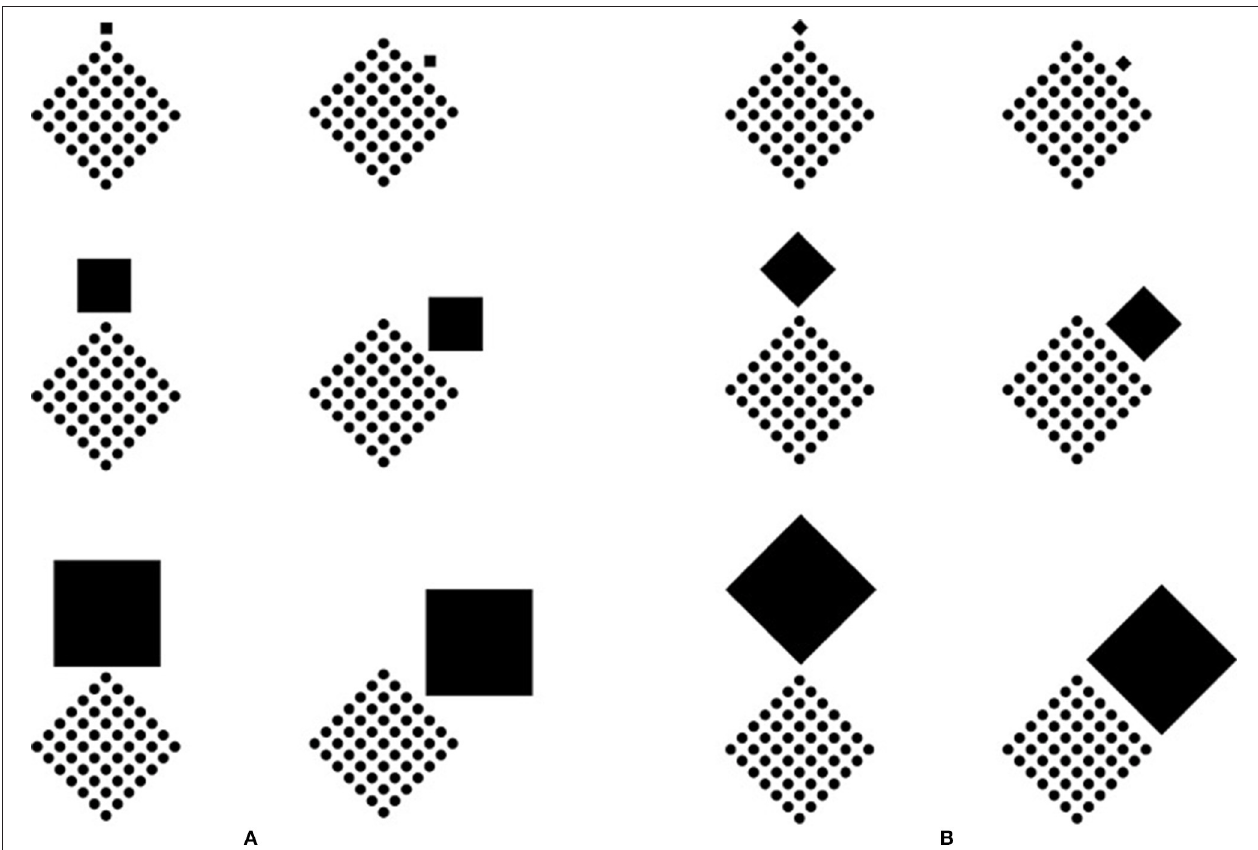
FIGURE 8 | By comparing all the conditions, both the dissimilar element [a square in (A) and a diamond in (B)], and the set of circles influence each other in the perceived grouping (for the circles, see the text) and in the shape [for both the array of circles and the dissimilar element, e.g., the large black shape is perceived as a square in the first column of (A) and in the second of (B), and as a diamond in the second column of (A) and in the first of (B)].